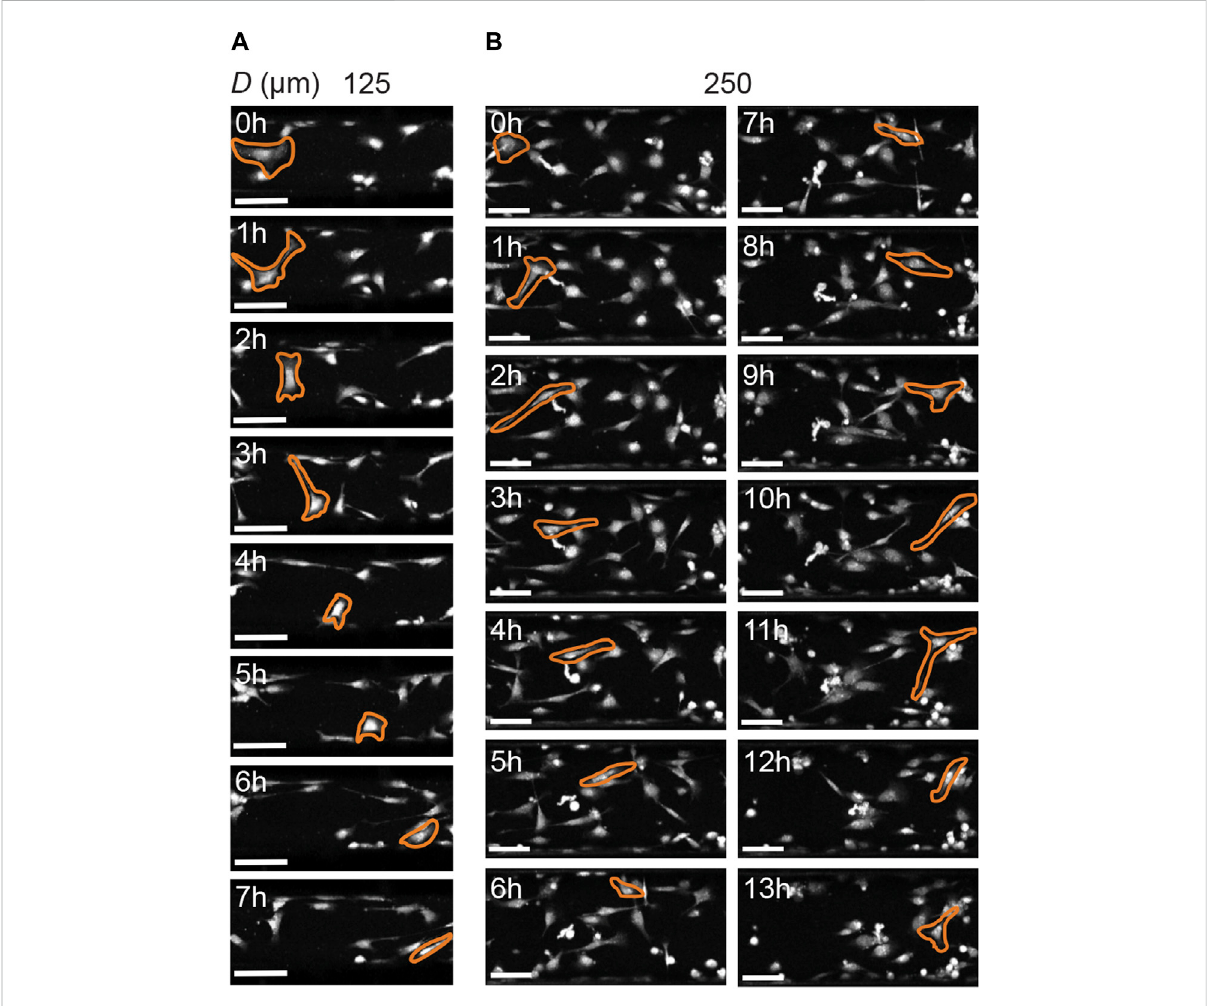
FIGURE 8 CellmorphologyofHCKcellsonconcavecylinders(longitudinalaxisfromlefttoright)duringmigration. (A) Cellsactivelyprobealldirectionson the smallest cylinder (125 µm), yet still favor migration in the longitudinal direction of the cylinder. (B) Similar observations for HCK cells on a larger cylinder (250 µm), where cells actively form protrusions in the circumferential direction, but favor migration along the cylinder axis. Scale bars: 100